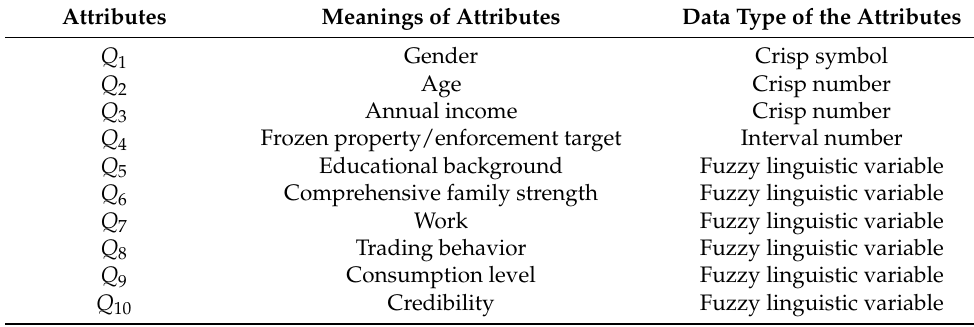
Table 2. The meanings of the attributes and their corresponding data types.